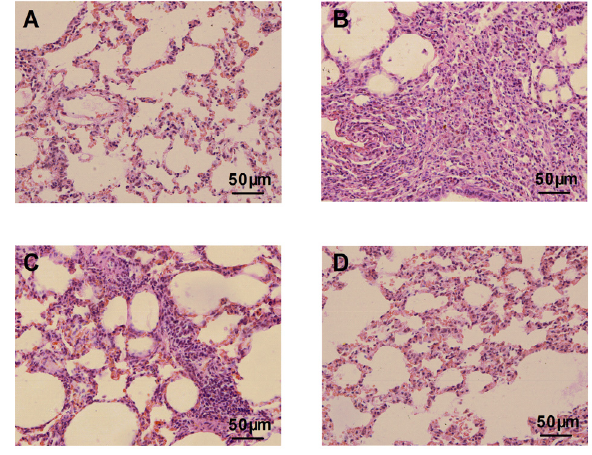
Figure 1. Histological evaluation of atorvastatin on bleomycin-induced lung in rats. ( A ) Lung tissue sections of control animals showing normal lung morphologies: thin lined interalveolar septa with well organized alveolar space; ( B ) Lung tissue sections of bleomycin-induced animals showing distorted lung morphologies: collapsed alveolar spaces with inflammatory exudates, wider and thickened interalveolar septa; ( C ) Lung tissue section of atorvastatin treated animals: lower inflammatory infiltrates with lessened alveolar thickening; and ( D ) Lung tissue section of atorvastatin alone administered animals showing similar morphology with that of control animals. Representative histological section of the lungs was stained by hematoxylin and eosin (×400).